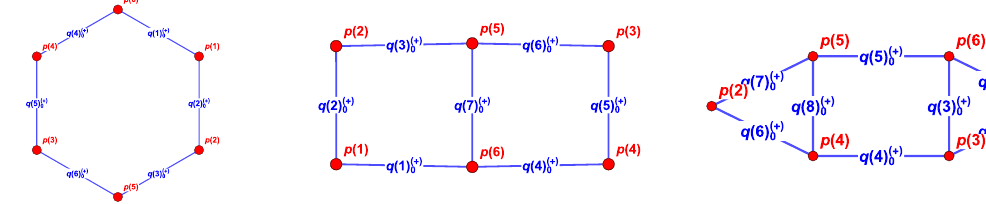
representation proposed in Ref. [87]. Clearly, the former will display several numerical instabilities w.r.t. the latter. Then